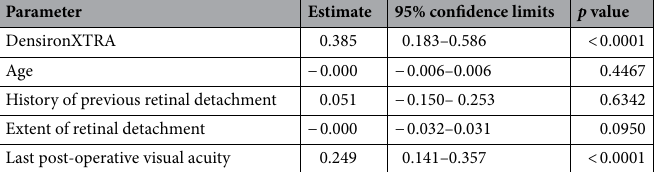
Parameter Estimate 95% confidence limits p